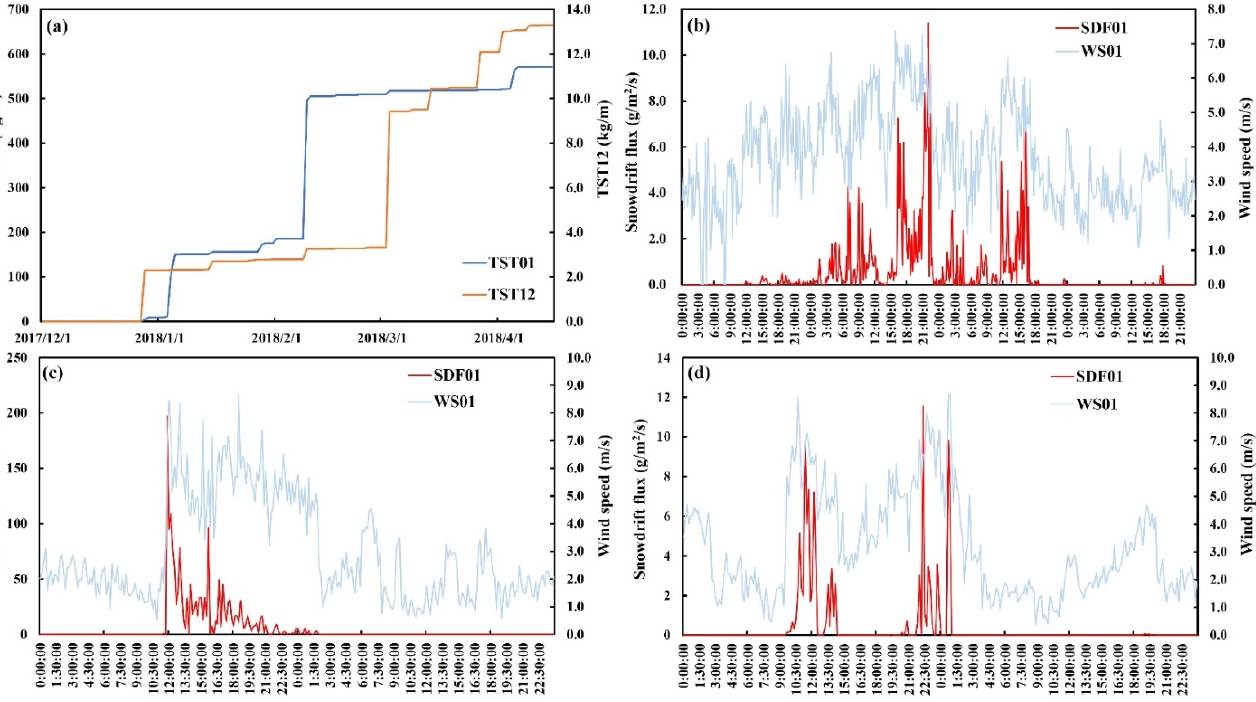
Figure 4. Total snow transport (TST) with different heights at the heights of 0~1 m (TST01) and 1~2 m (TST12) ( a ), and 10-min mean snowdrift fluxes and wind speeds of typical Event 1 ( b ), 2 ( c ) and 3 ( d